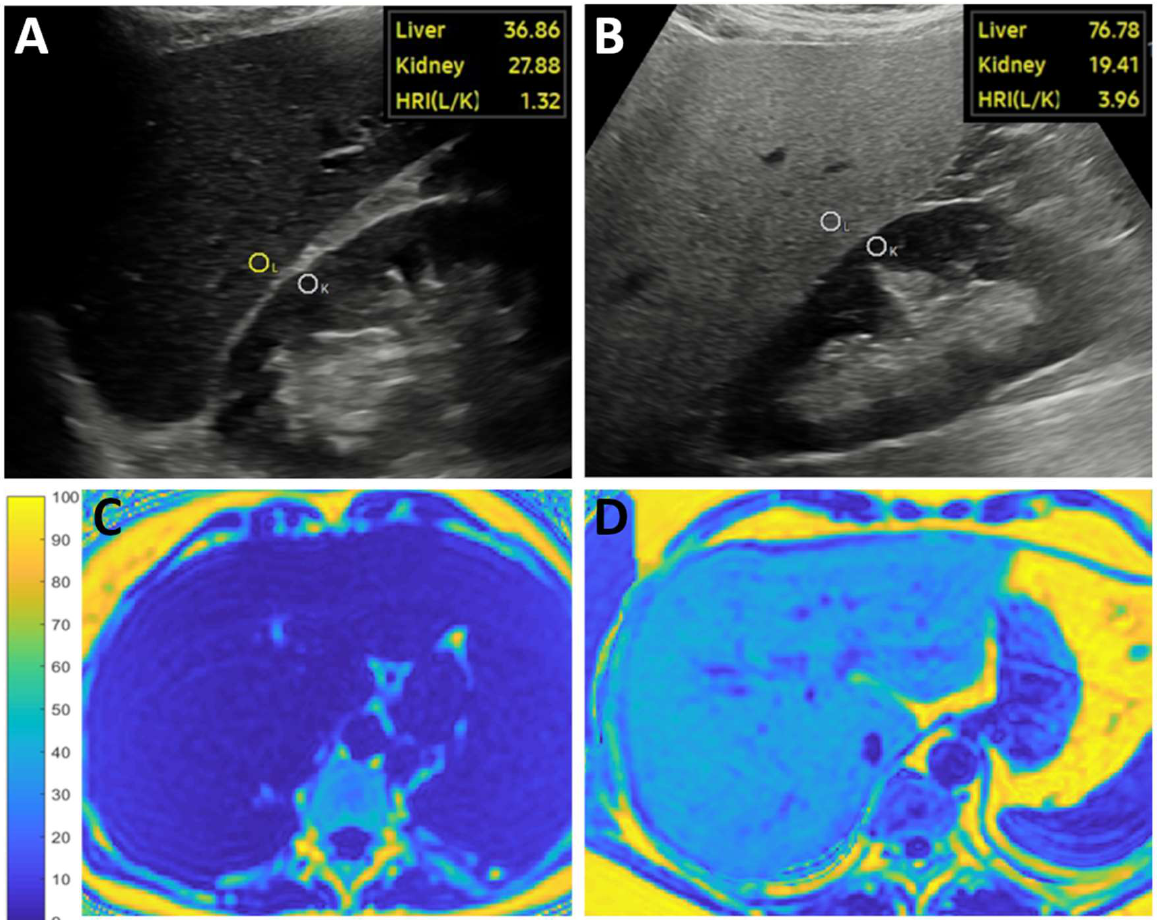
Figure 2. Representative images show measurements of the artificial intelligence-calculated hepatorenal index (HRI) and magnetic resonance imaging fat fraction (MRI-PDFF). The examiner took a longitudinal brightness mode image of the right liver lobe and the right kidney. The HRI was calculated from the pixel intensity ratio of two circular regions of interest (ROI) automatically placed in the liver (L) and the kidney cortex (K) by the software after segmentation of the ultrasound image with a deep convolutional neural network. ( A ) The brightness of a non-steatotic liver was similar to the kidney’s cortex resulting in a low HRI. ( B ) The brightness of a severely steatotic liver was much higher than the kidney’s cortex, causing an elevated HRI in a patient diagnosed with NAFLD. The MRI-PDFF maps reconstructed with a complex method were used as a reference. ( C ) In the first cases, the blue color of a non-steatotic liver corresponded to <5% MRI-PDFF on the scale ranging from 0–100%. ( D ) Meanwhile, severe steatosis ( ≥ 20% MRI-PDFF) was indicated by the turquoise color of the liver in the second case.